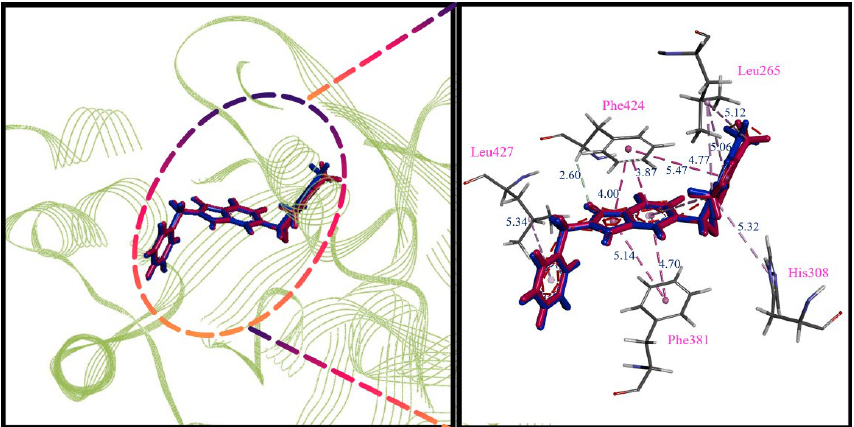
Figure 4. Alignment of the redocked ligands with the native ligand in the crystallographic complex. Redocked ligand is cyan, the native ligand is red. Green is the distance of the interaction (Å).